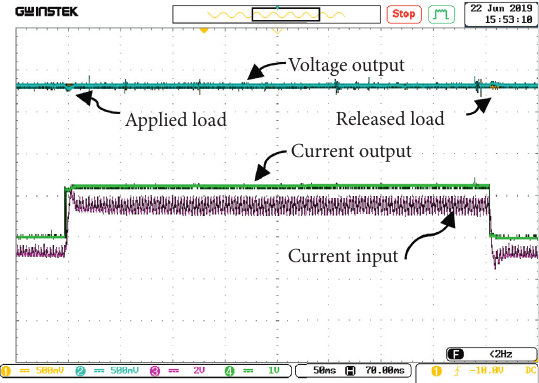
Figure 17: Result of inductor current when compared to switch operation of the four-phase interleaved boost converter circuit.